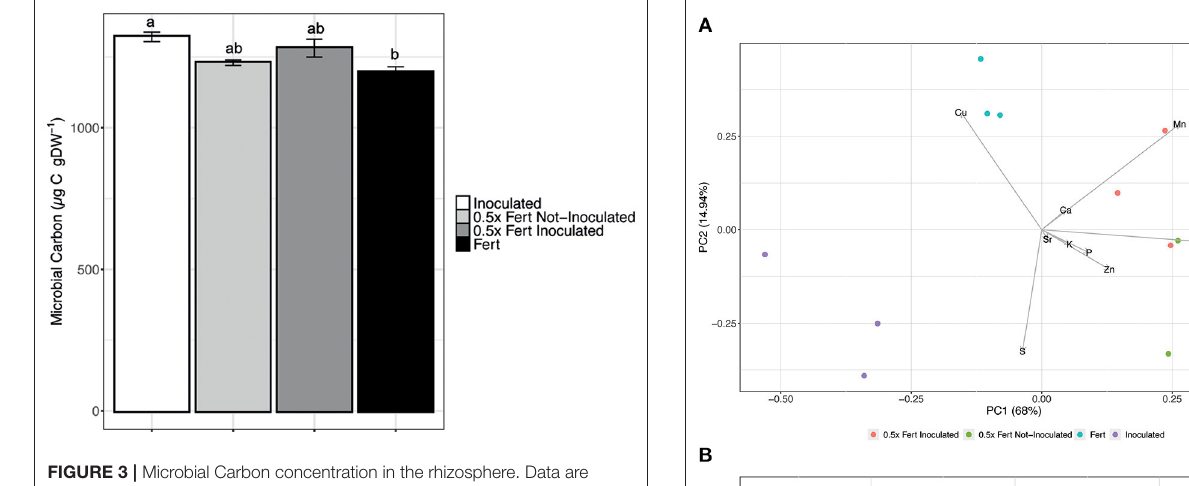
FIGURE 3 | Microbial Carbon concentration in the rhizosphere. Data are reported as means ± SE. Different letters indicate significant differences according to one-way ANOVA with Tukey post-hoc tests ( p < 0.05).